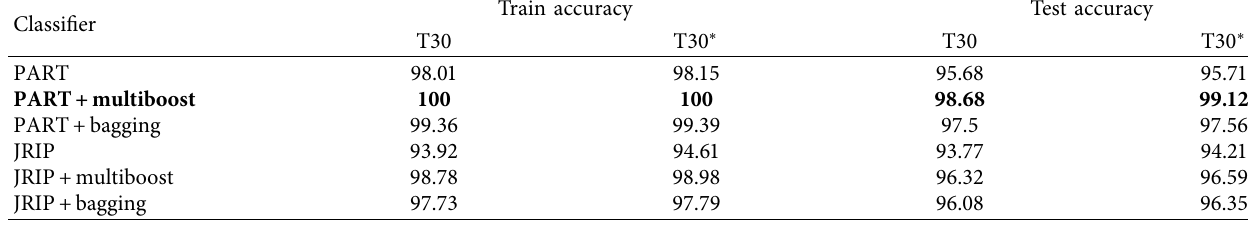
Table 14: Classifier performance in terms of train accuracy and test accuracy values for Exp. 5.